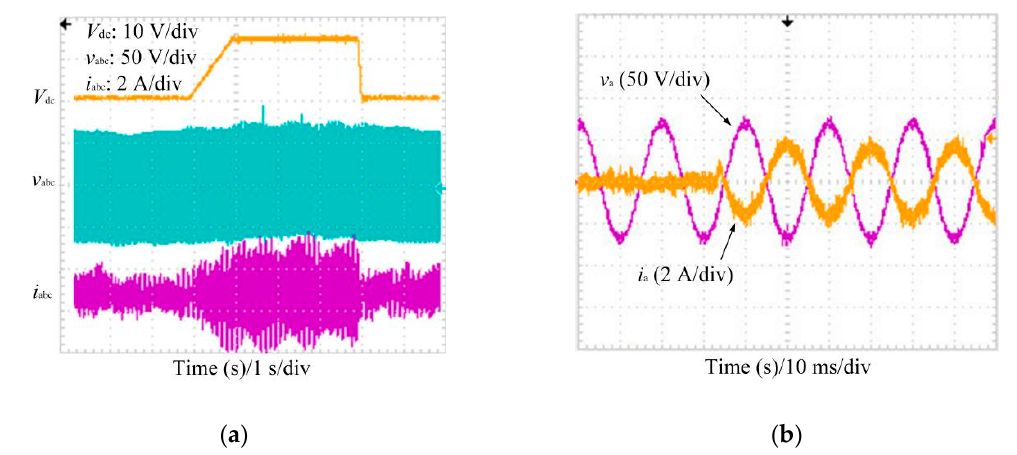
Figure 21. The results of the system bi-directional flow experiment: ( a ) the phase voltage and the phase current of the AC side in the inverter feedback mode; and ( b ) the phase voltage and the phase current of the AC side in the traction mode.